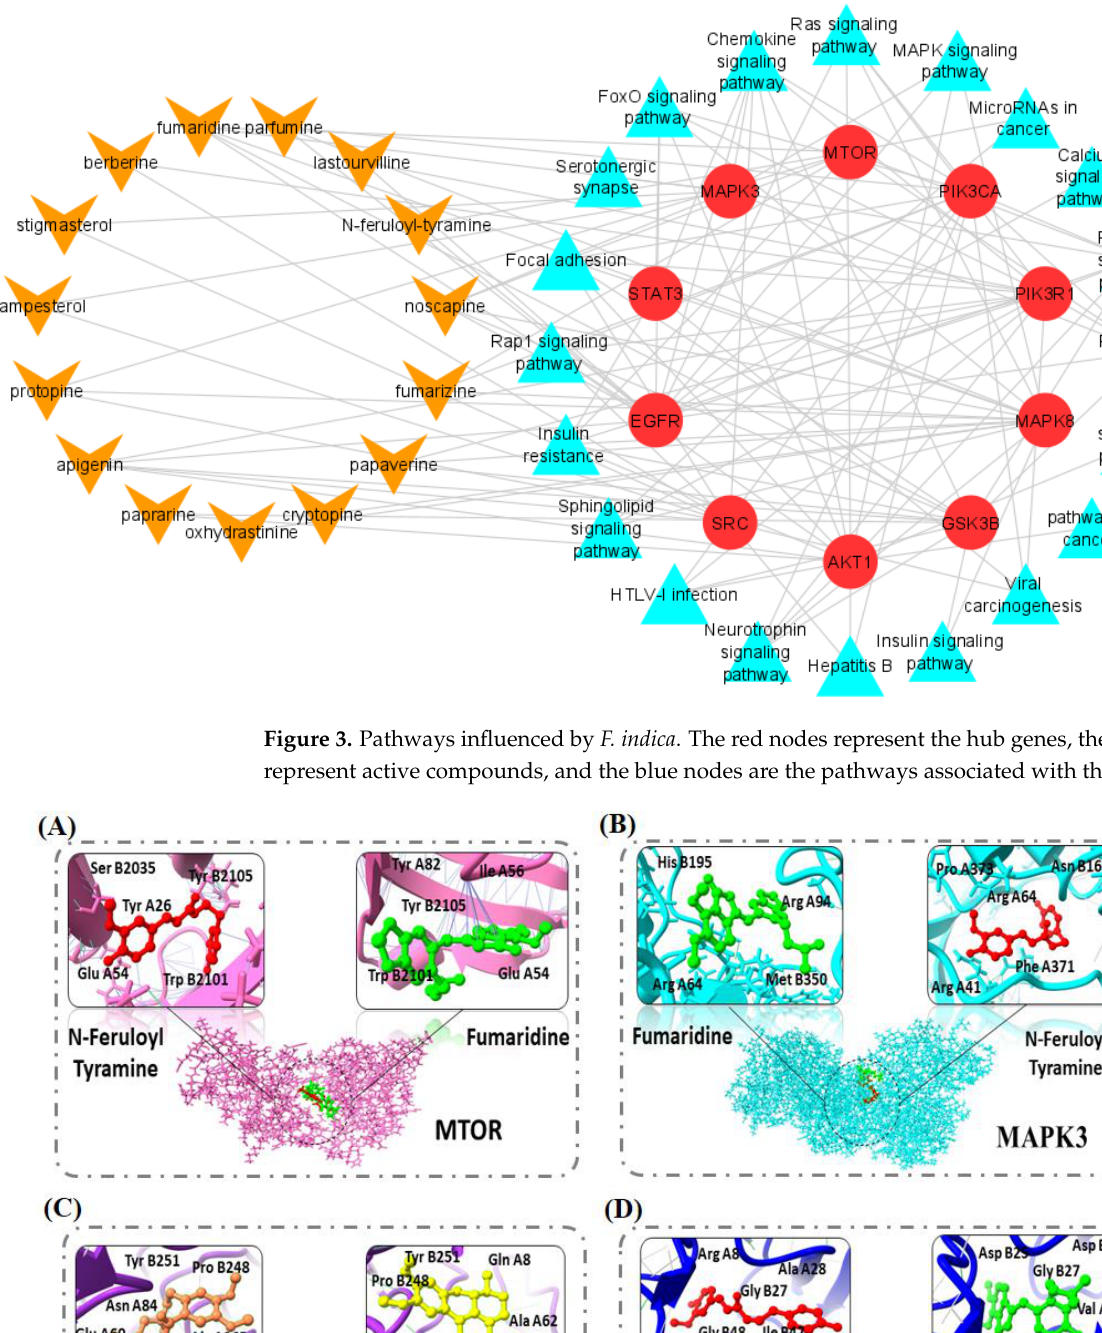
Figure 3. Pathways influenced by F. indica . The red nodes represent the hub genes, the orange nodes Figure 2. Representation of functional annotation and enriched pathways in form of Bubble Plot. represent active compounds, and the blue nodes are the pathways associated with the core targets. ( A ) GO in terms of biological processes. ( B ) GO in terms of molecular function. ( C ) GO in terms of cellular components. ( D ) KEGG pathway analysis.